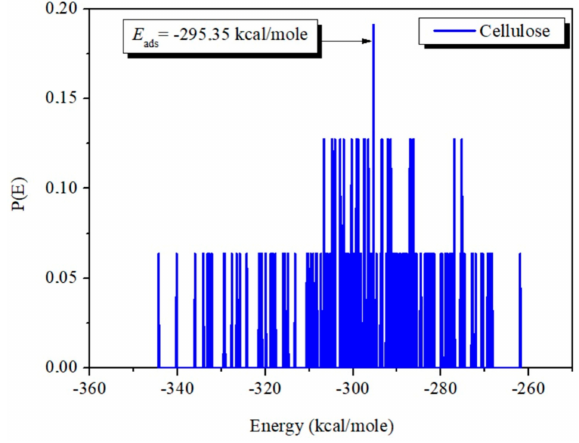
Figure 12. Distribution of the E ads of the biopolymer CHA inhibitor via MC simulation.